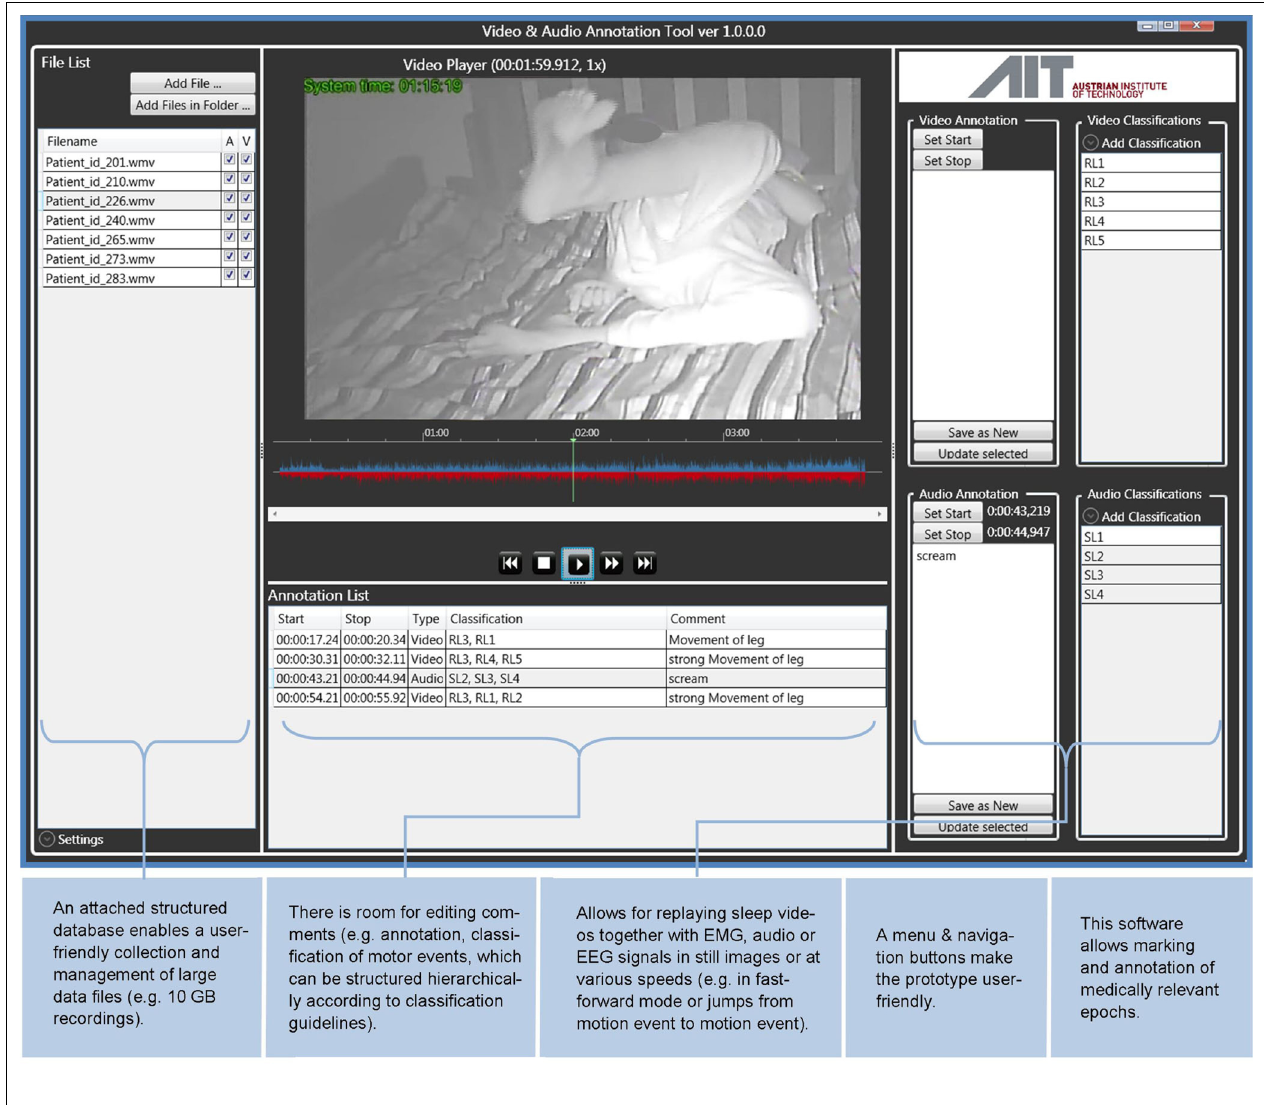
Institutes of Technology), which allows for viewing at multiple speeds, annotation, marking, and archiving of files in one interface, and eases the process of quantifying descriptive results and generating